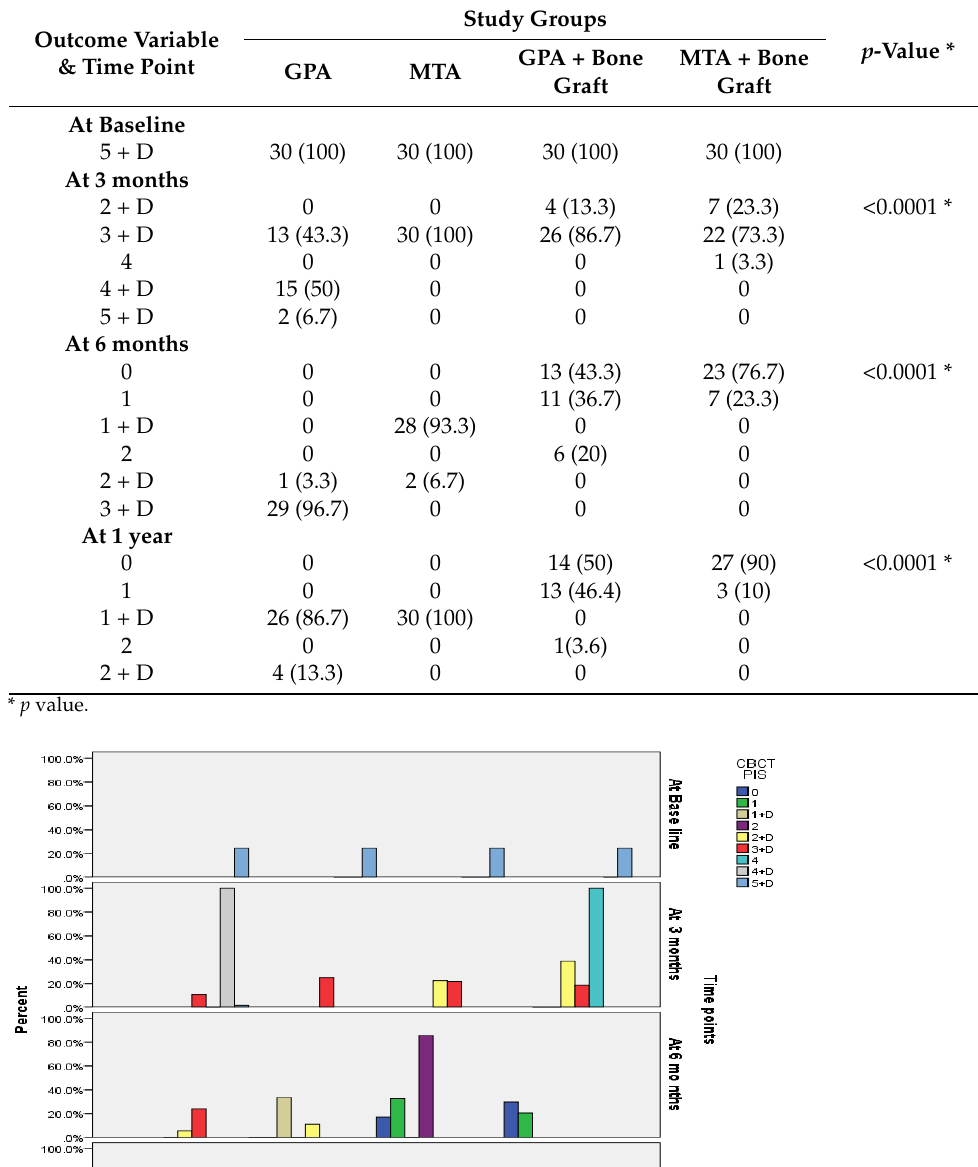
Table 3. Comparison of distribution of CBCTPAI among the 4 study groups at each of the 4 time points of follow up visits.